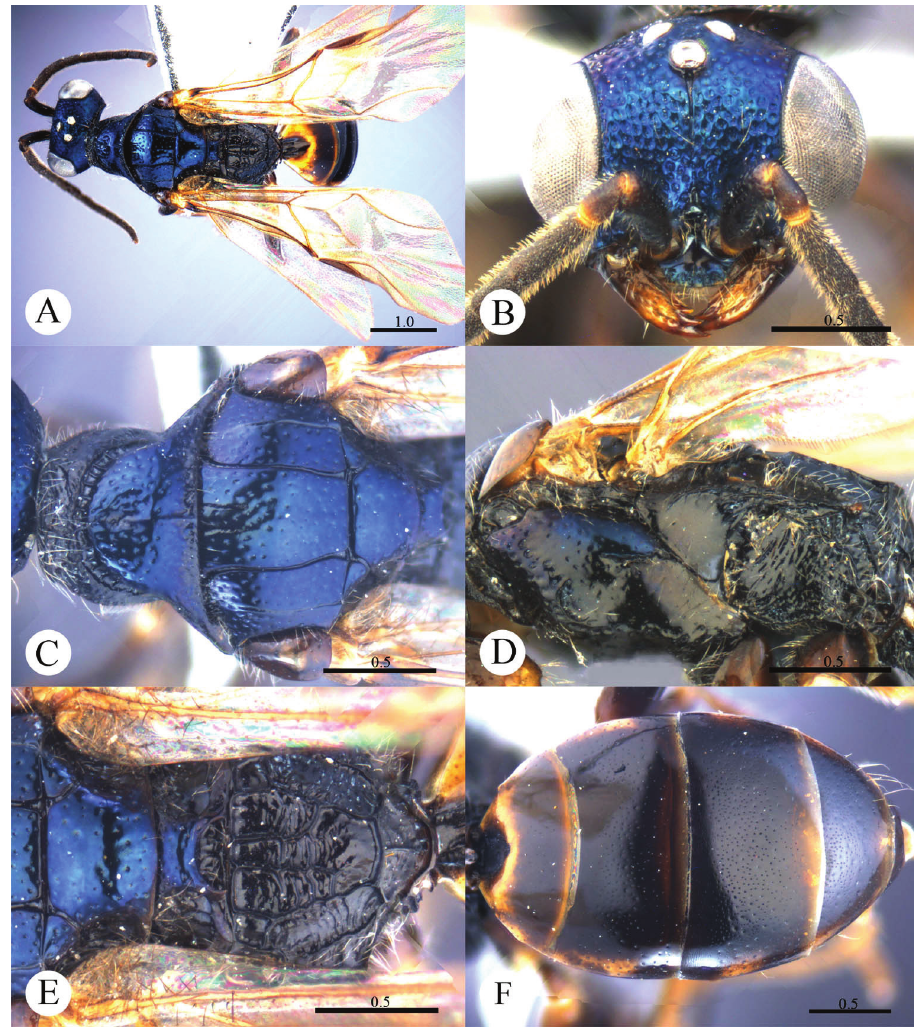
Plate 11. Cleptes sinensis sp. n., holotype, male. A Habitus dorsal B Head anterior C Pronotum and mes- oscutum dorsal D Mesopleuron and metapleuron lateral e Mesoscutellum, metanotum and propodeum dorsal F Metasoma dorsal. Scale bars in